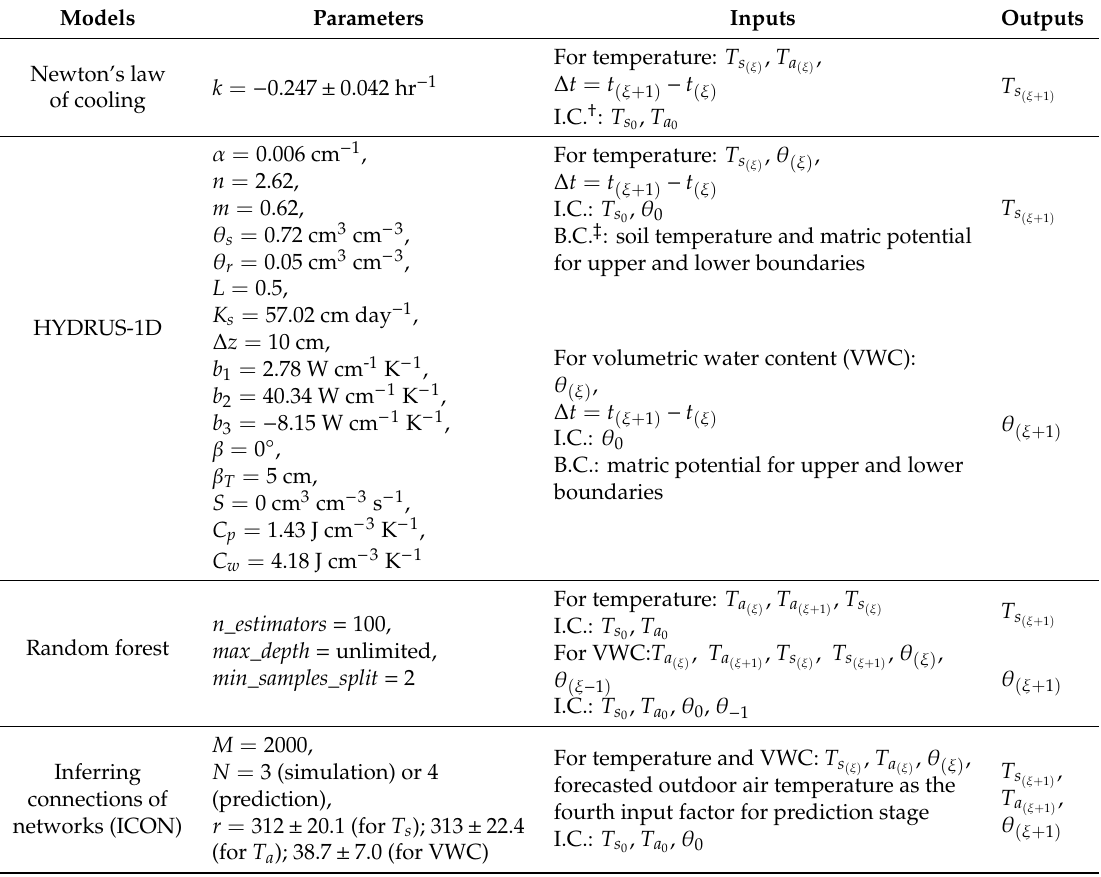
Table 1. Inputs and outputs of the studied